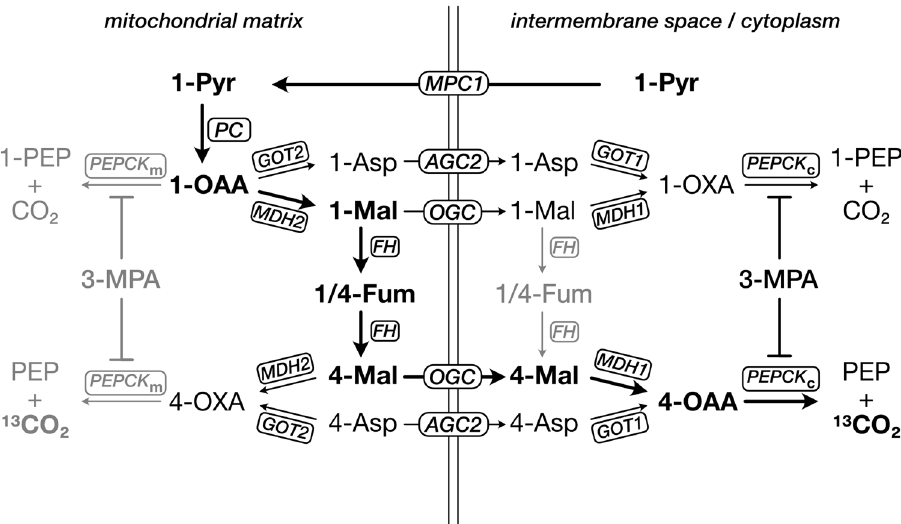
Fig. 5 Simpli fi ed schematic depicting the route of [1- 13 C]pyruvate (1-Pyr) to [4- 13 C]oxaloacetate (4-OAA) to yield [ 13 C]bicarbonate from PEPCK fl ux. Pyruvate carboxylation takes place in the mitochondrion and transporters of the malate-aspartate shuttle facilitate export to the cytoplasm. Label exchange of malate from the 1- to 4-position is mediated by fumarase (FH). Reversible reactions and transport steps between PC and PEPCK are indicated as unidirectional for simplicity and to illustrate label fl ow. The main route to cytoplasmic 4-OAA is indicated in bold. MPC1, mitochondrial pyruvate carrier-1; GOT, glutamate oxaloacetate aminotransferase; MDH, malate dehydrogenase; AGC2, aspartate-glutamate antiporter; OGC, 2-oxoglutarate/malate carrier; PEPCK m , mitochondrial PEPCK; PEPCK c , cytoplasmic